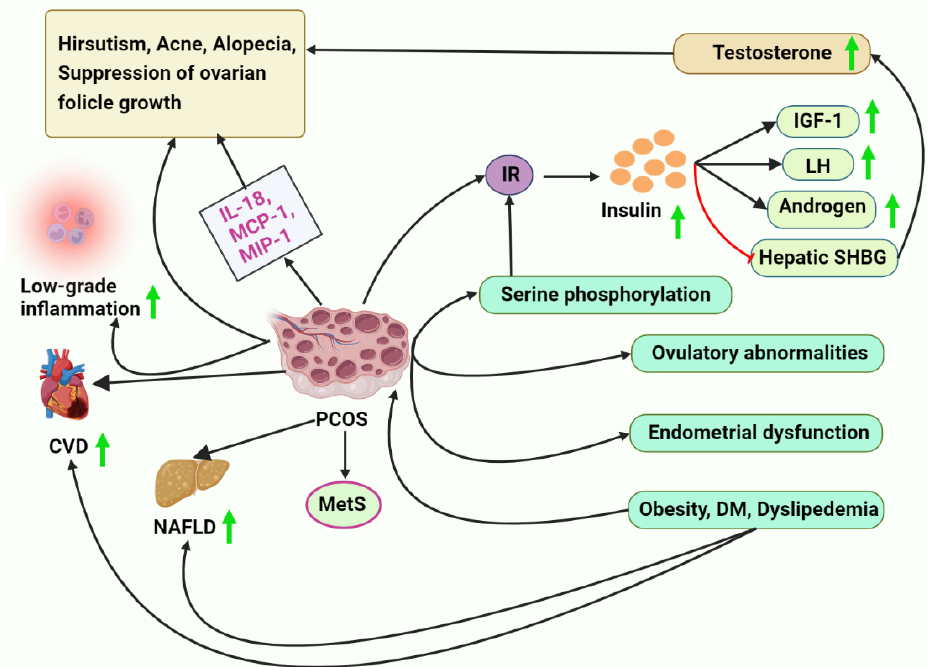
Figure 1. This figure represents various aspects of PCOS. PCOS increases the risk of NAFLD, CVD, and other MetS. Additionally, PCOS leads to serine phosphorylation, ovulatory abnormalities, and endometrial dysfunction. Obesity and dyslipidemia also pose a risk for PCOS.